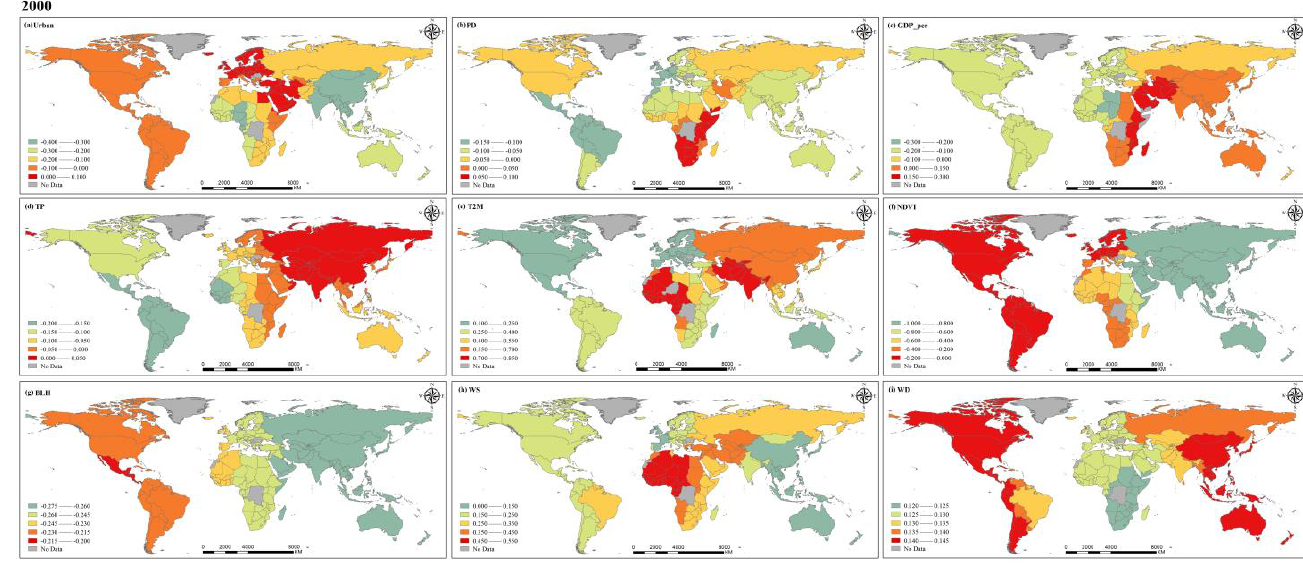
Figure 13. Spatial distribution of coefficients for factors in 2000.